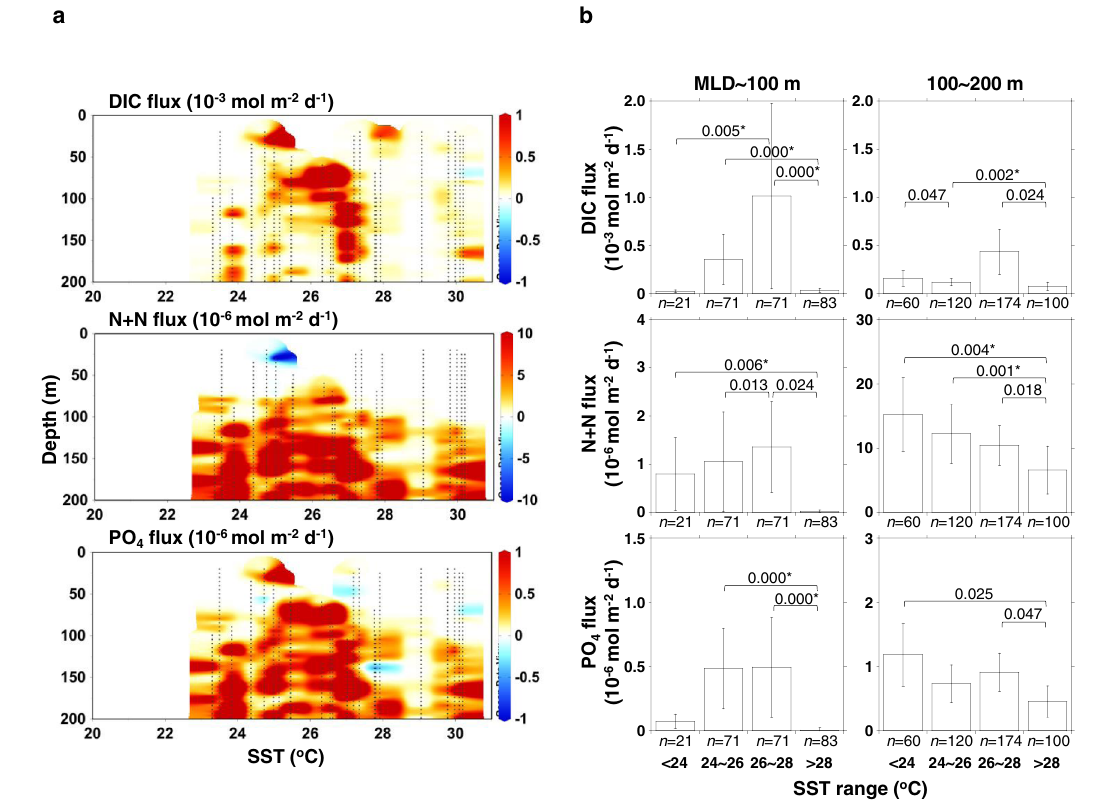
Fig. 3 Vertical fl uxes of dissolved inorganic carbon (DIC), nitrate plus nitrite (N + N), and phosphate (PO 4 ) over sea surface temperature (SST) in the layer between the mixed layer depth (MLD) and 200-m depth of the western subtropical North Paci fi c. a Vertical pro fi les of DIC, N + N, and PO 4 fl uxes plotted against SST. The small black dots denote the depths where K z data were obtained. b Mean fl uxes of DIC, N + N, and PO 4 in four different SST regimes within the MLD~100 m (left) and 100~200m (right) layers shown in a . The error bars denote the 95% con fi dence interval (CI). Signi fi cant differences (two-sided Kruskal-Wallis test, P < 0.05) in the mean fl uxes between the SST regimes are stated just above the bars. Signi fi cant differences of multiple comparisons with the Dunn ’ s procedure after the Kruskal-Wallis test ( P < 0.0083) are marked with an asterisk